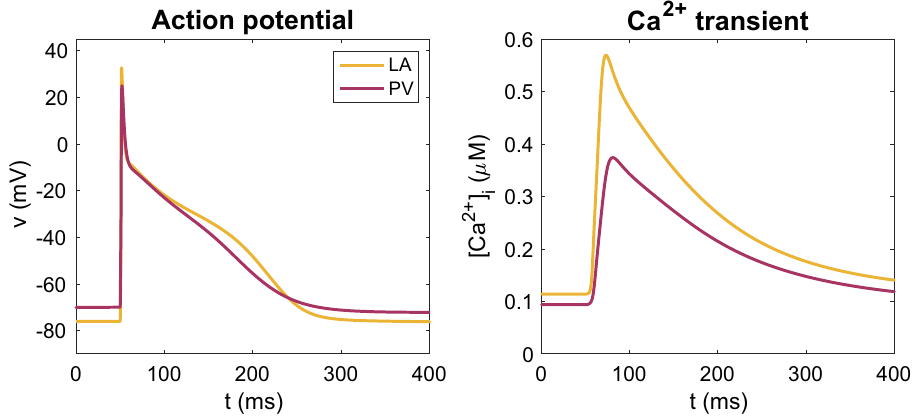
2 + Figure 2. Action potentials (left) and [ Ca ] transients (right) for the LA and PV versions of our base model obtained at steady-state in response to a 1 Hz stimulus train.